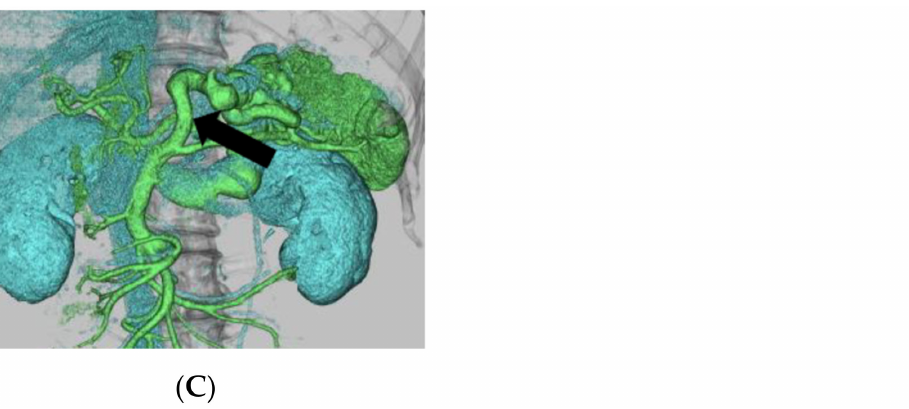
Figure 2. Inflow tract for gastric varices assessed by three-dimensional-computed tomography (3D- CT). Inflow tract for gastric varices before performing balloon-occluded retrograde transvenous obliteration (BRTO) was confirmed by 3D-CT. Inflow tract for gastric varices was from ( A ) short gastric vein (SGV) (non-LGV group), ( B ) SGV and posterior gastric vein (PGV) (non-LGV group), or ( C ) left gastric vein (LGV